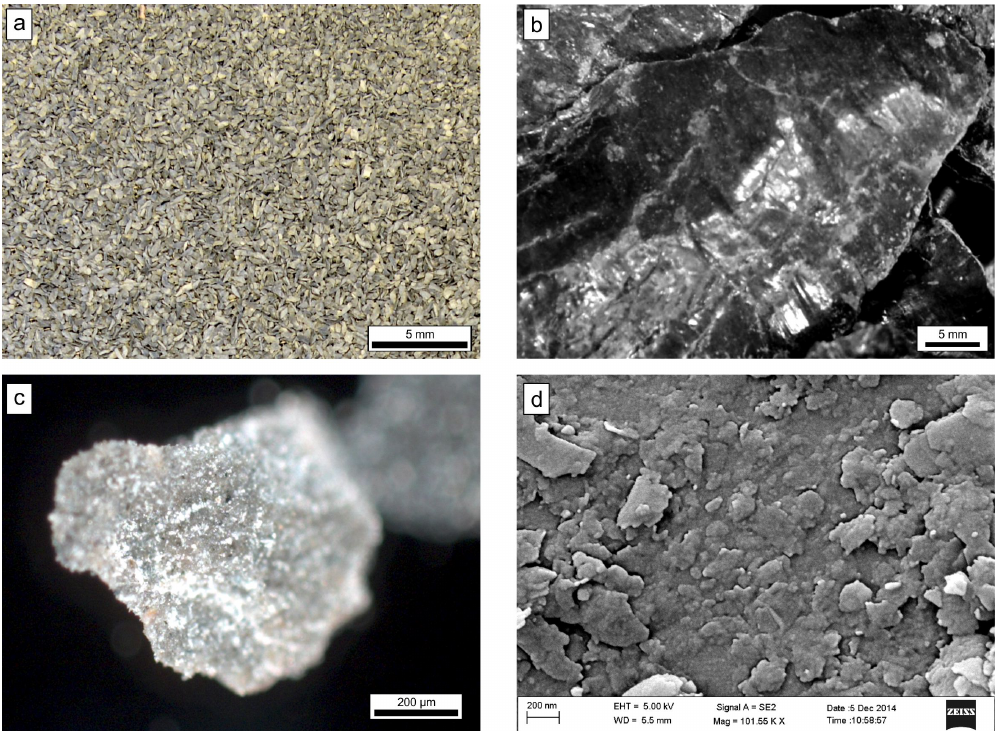
Figure 6. (a) Photograph of microlithons which passed the 0.25mm but not the 0.125mm sieve. Note the smooth, polished slickensided surface of the microlithons ( b and c ). (d) shows the surface in high-resolution SEM to be composed of elongated clay particles, which are only tens of nm wide and oriented parallel to the surface. This structure is identical to slickensided surfaces presented in Laurich et al. (2014).